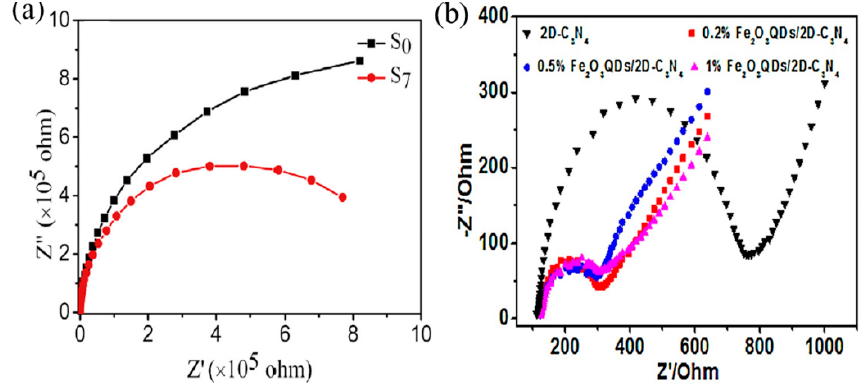
Figure 18. EIS Nyquist plots of ( a ) S 0 and S 7 samples, ( b ) 2D-C 3 N 4 , 0.2% Fe 2 O 3 QDs/2D-C 3 N 4 , 0.5%